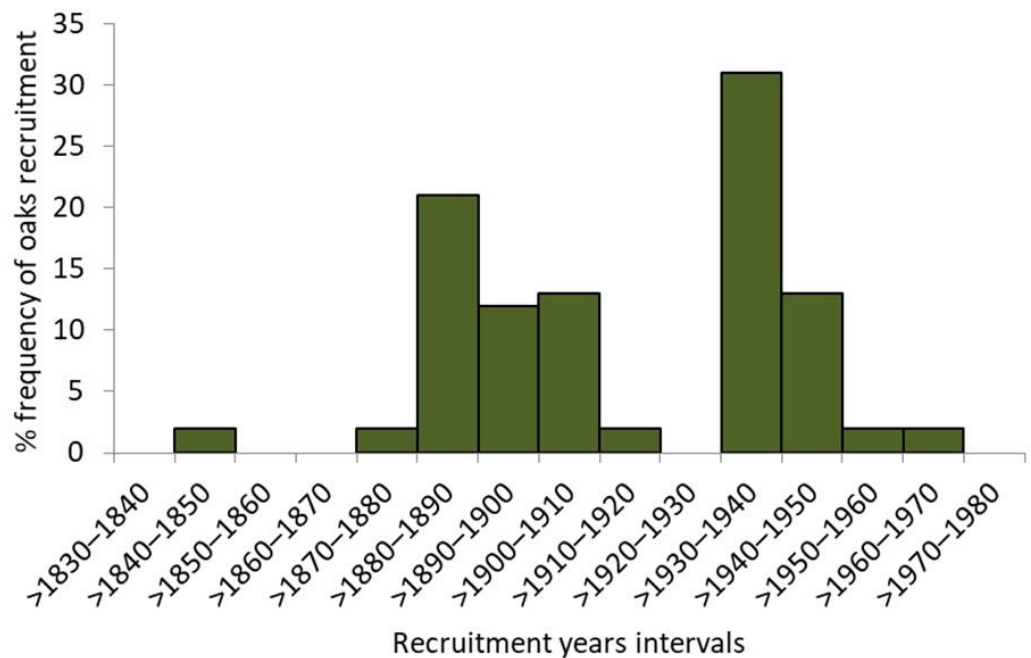
Forests 2021 , 12 , x FOR PEER REVIEW